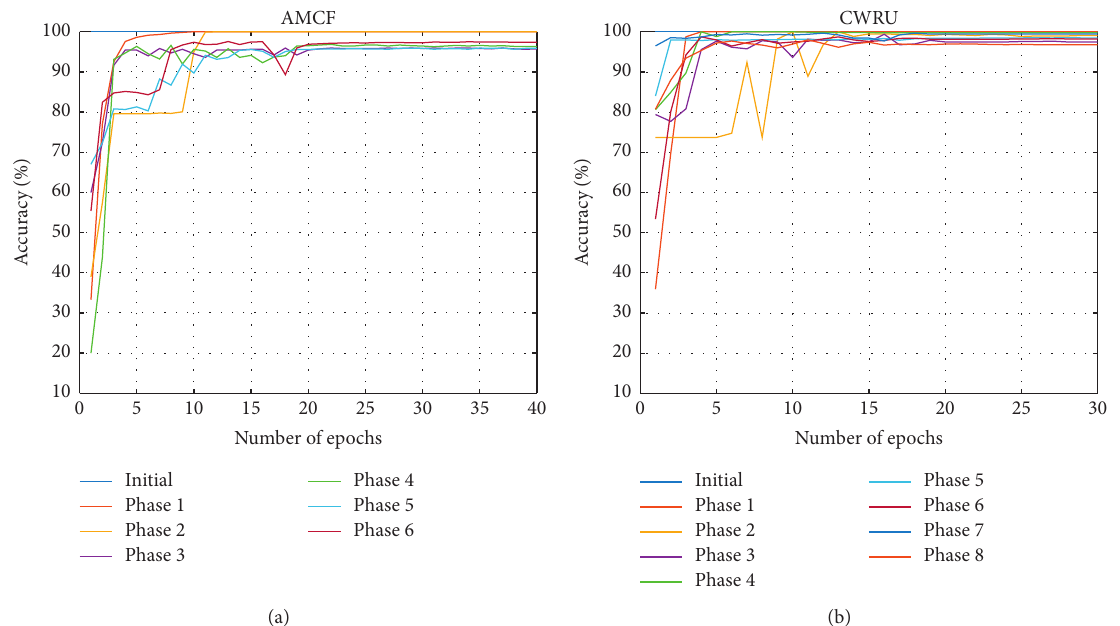
Figure 3: Accuracy performance of 1D CNN (FT +H) across different epochs. We show the accuracy performance for the different incremental phases.